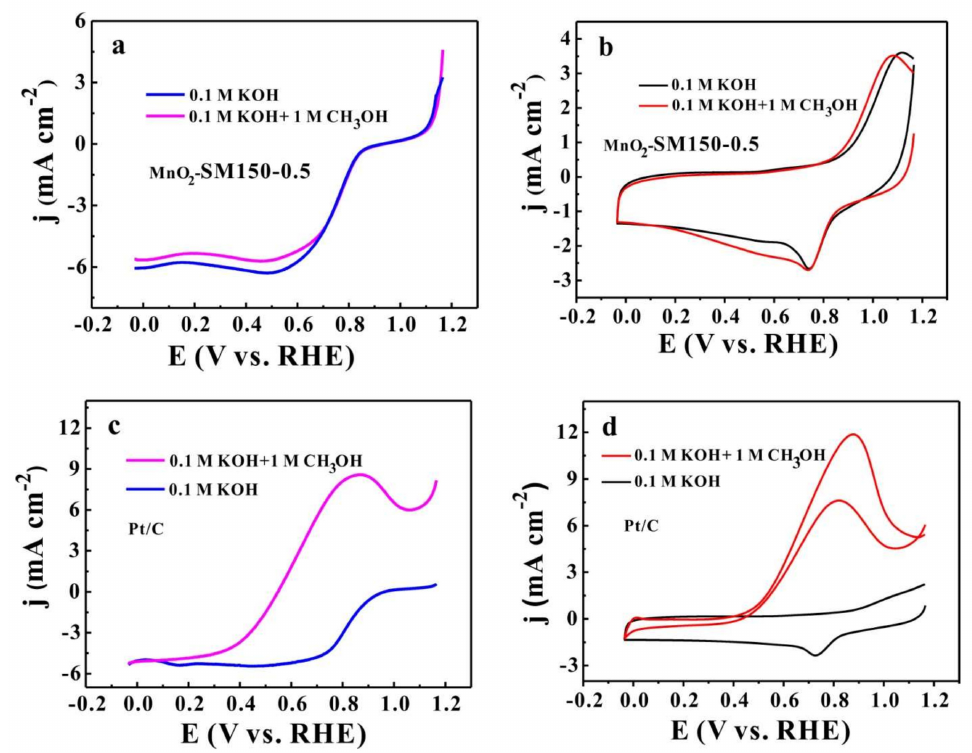
Figure 8. LSV curves of MnO 2 -SM150-0.5 ( a ) and Pt/C ( c ) in an O 2 -saturated 0.1 M of KOH electrolyte with (purple line) and without (blue line) 1.0 M methanol; cyclic voltammetry (CV) curves of MnO 2 -SM150-0.5 ( b ) and Pt/C ( d ) at 20 mV s − 1 in an O 2 -saturated 0.1 M of KOH electrolyte with (red line) and without (black line) 1.0 M